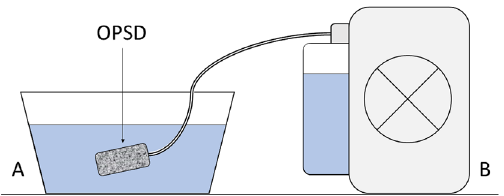
Figure 1. Experimental setup. ( A ) Water container, ( B ) Electric vacuum pump with water canister, OPSD: Open-pore suction device (for tested OPSD see Fig.